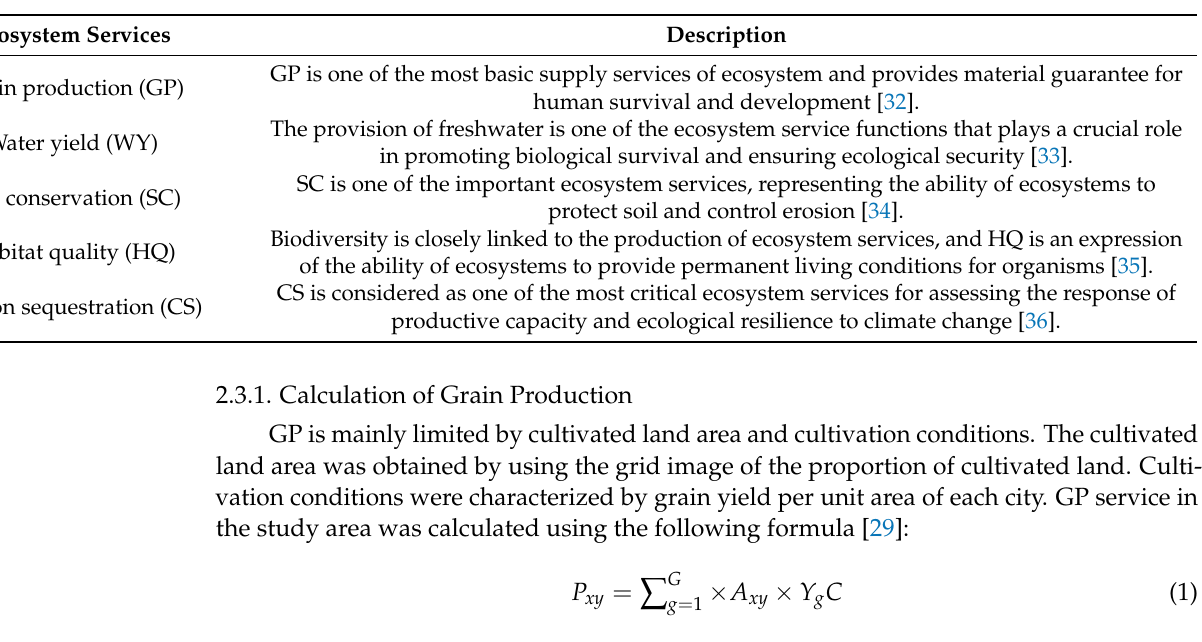
Table 2. Descriptions of the selected ecosystem